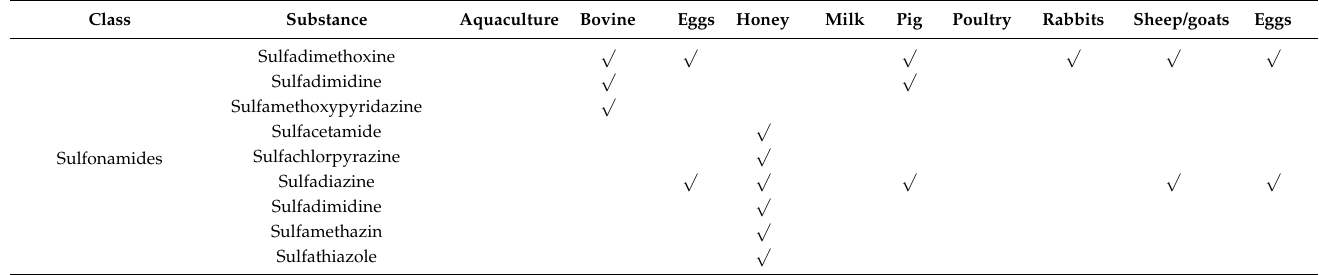
Figure 2. Structures of representative compounds from each class of antibiotics. Table 1 compiles the classes of veterinary drugs most used in the EU according to the EFSA report on “monitoring of veterinary medicinal product residues and other substances in live animals and animal products” [16]. Table 1. Summary of the Appendix A (List of non-compliant results: targeted sampling) of the technical report of the monitoring data collected in 2018 on the presence of residues of veterinary medicinal products and certain substances in live animals and animal products in the European Union. European Food Safety Authority. Approved: 20 December